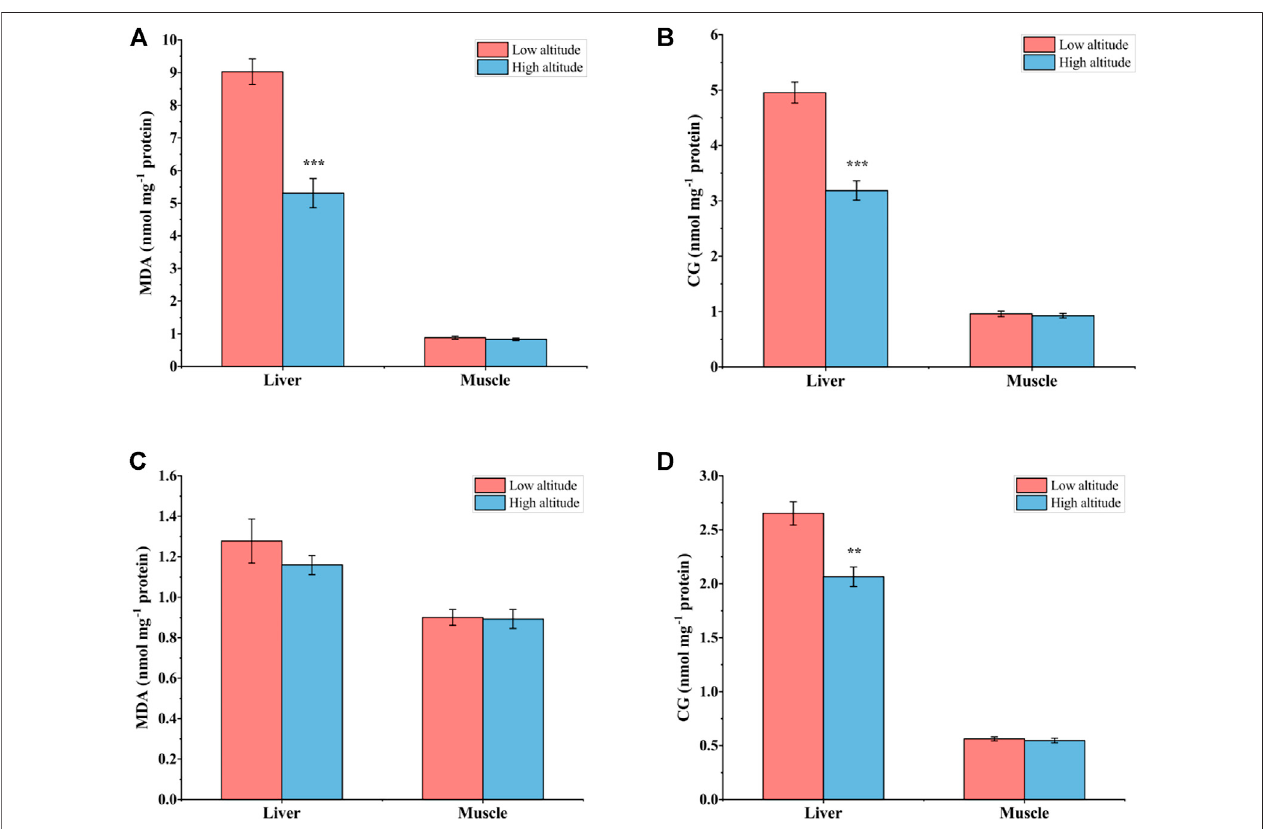
FIGURE 3 | Malondialdehyde (MDA) (A) and carbonyl groups (CG) (B) in liver and muscle of low-altitude and high-altitude adult frogs, and comparable values for juvenile frogs (C,D) . Data are presented as mean ± SEM ( n = 8). Asterisks (** p < 0.01, *** p < 0.001) indicate signi fi cant differences between two populations.